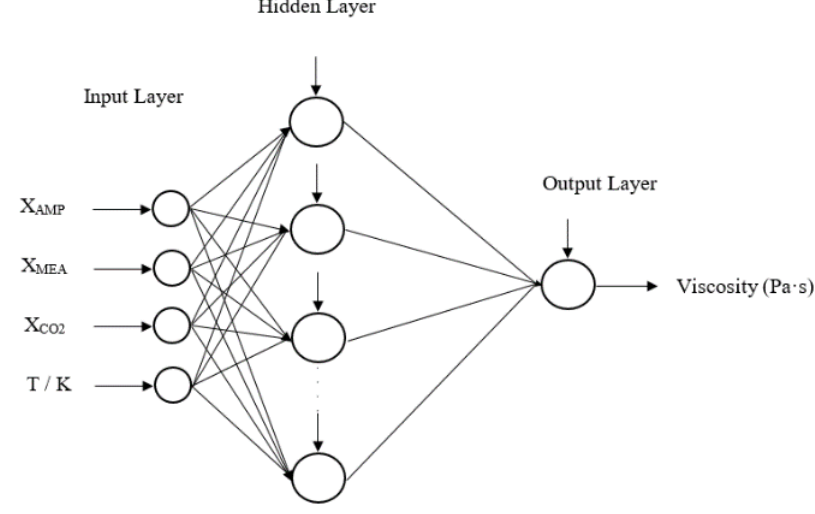
Table 3. Number of data used in amine mixtures.